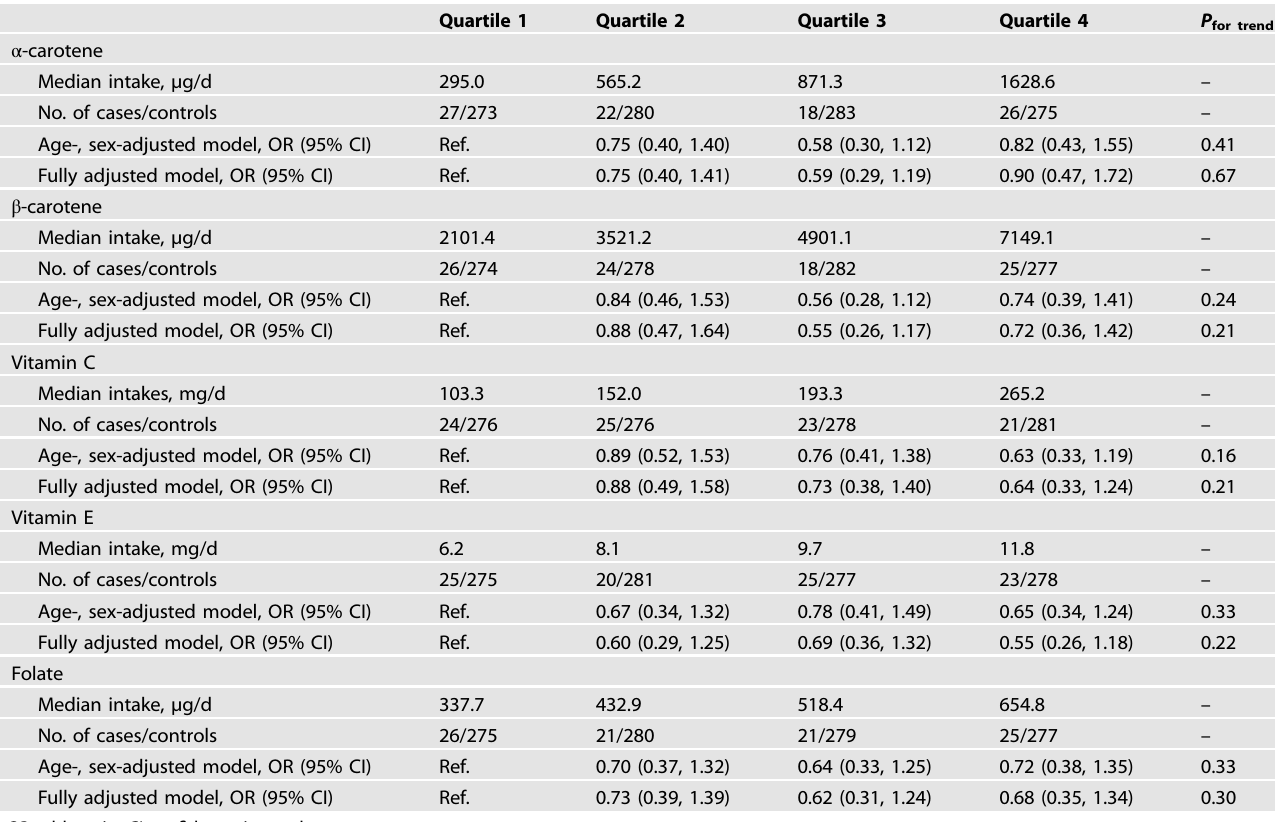
Table 3. Odds of major depressive disorder according to quartiles of nutrient